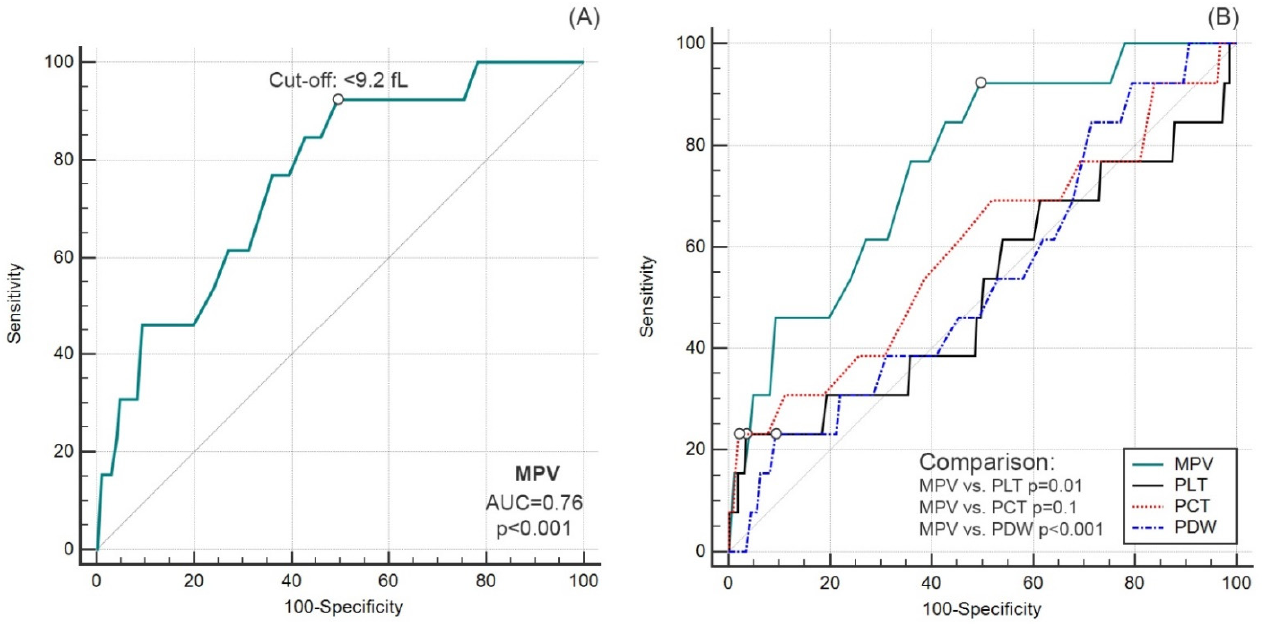
Figure 2. Diagnostic accuracy of MPV ( A ) and comparison of ROC curves for other platelet param ‐ eters ( B ).